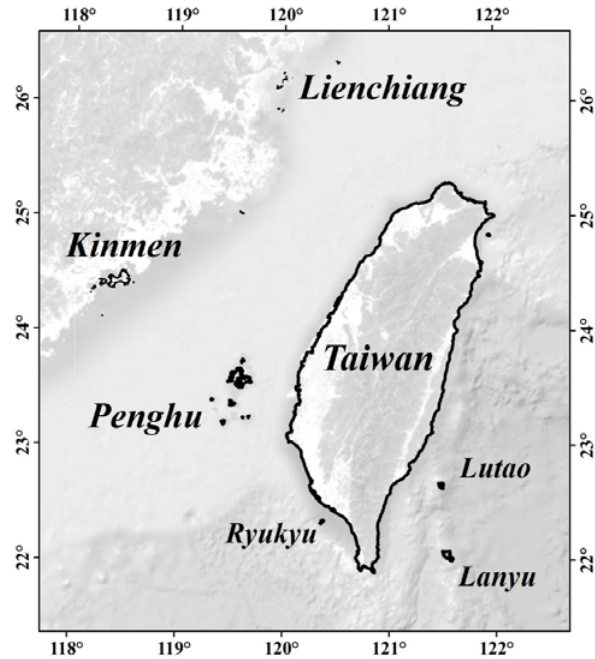
Figure 1. Map of Taiwan and its remote islands.